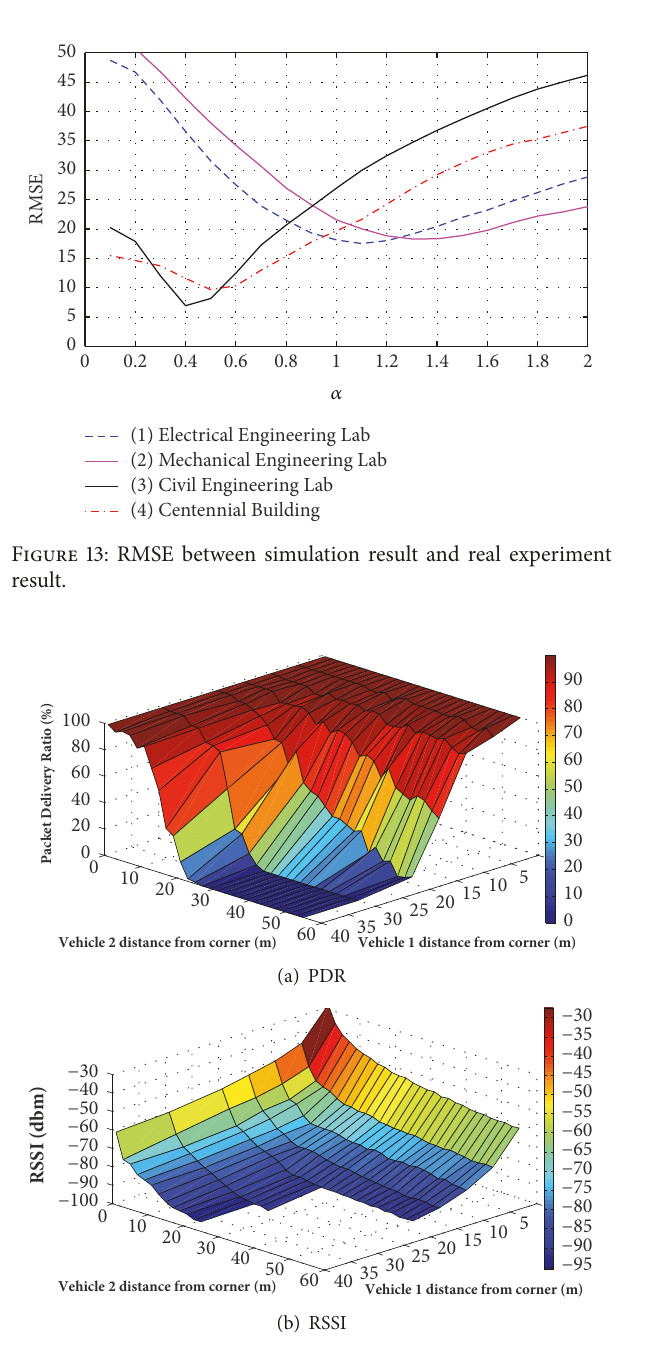
Figure 14: Results from the simulation with 𝛼 = 1.1 for blind corner with large obstruction. (a) PDR. (b) RSSI.